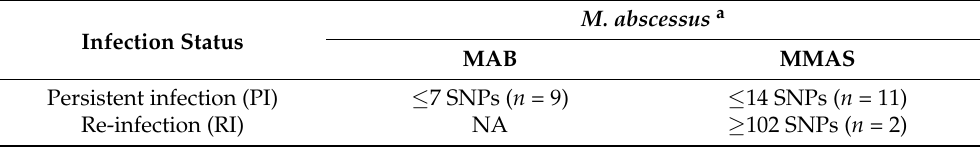
Table 1. SNP cut-off values used to differentiate between re-infection and persistent infection caused by M. abscessus